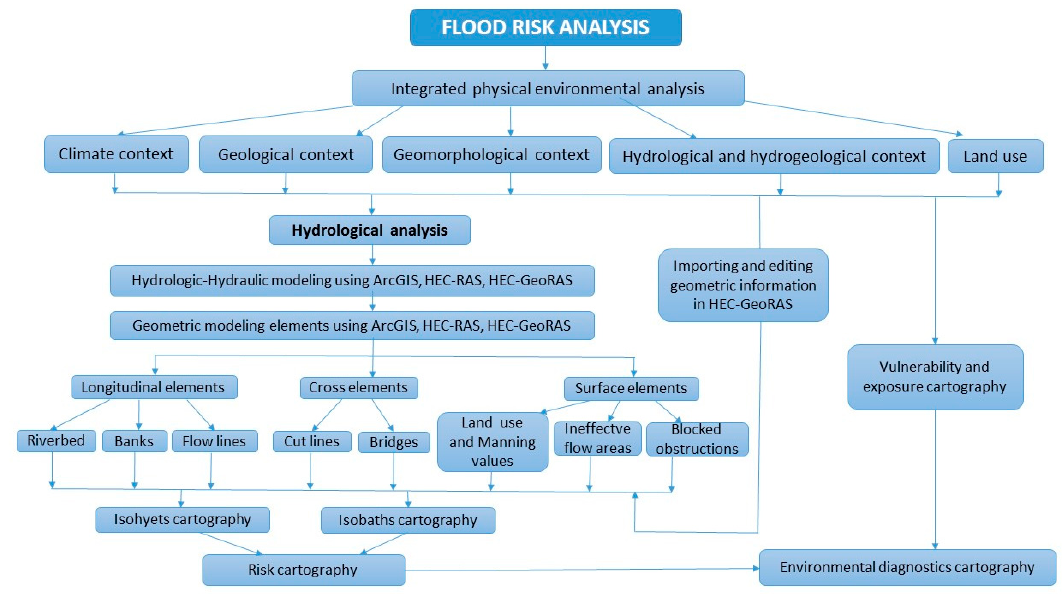
Figure 2. Methodology followed for analyzing flood risk.